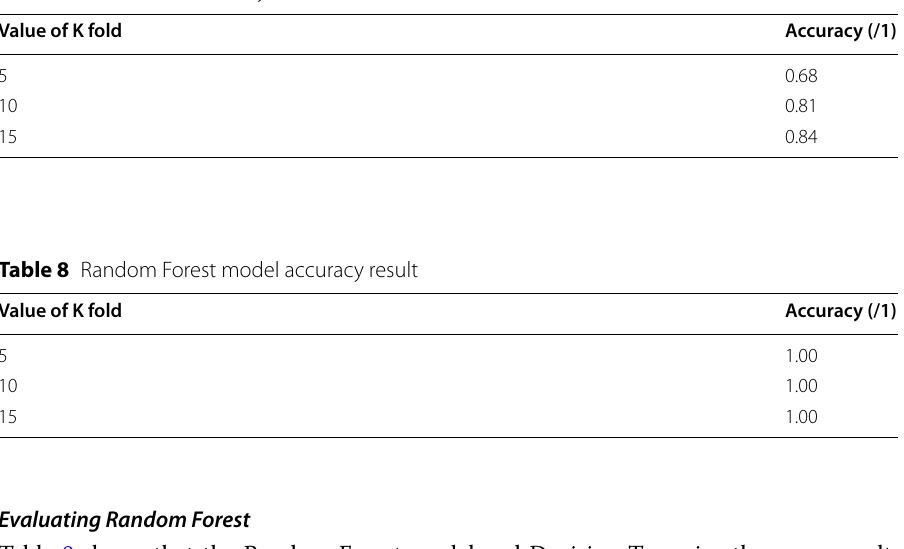
Table 7 SVM model accuracy